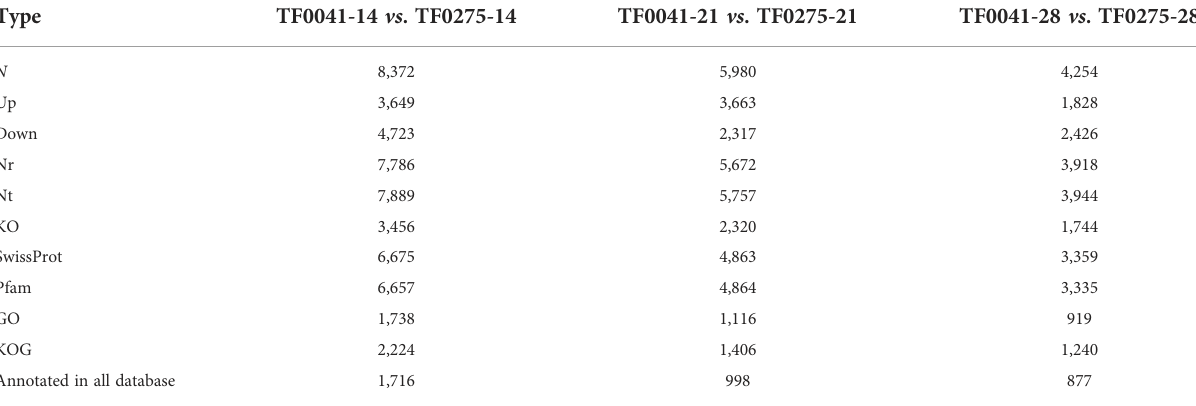
TABLE 6 Statistical table of the differently expressed transcripts (DEGs), with